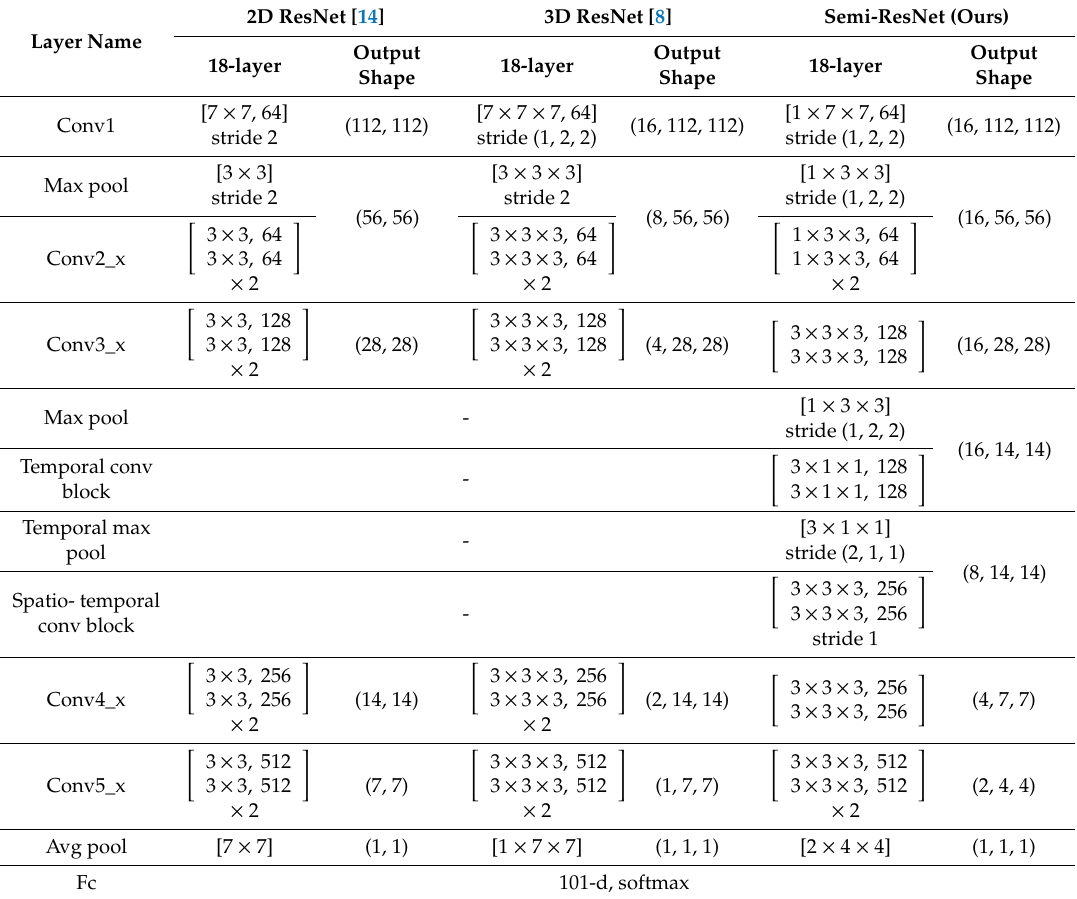
Table A1. Configuration comparison for 2D ResNet, 3D ResNet and our semi-ResNet, for an 18-layers